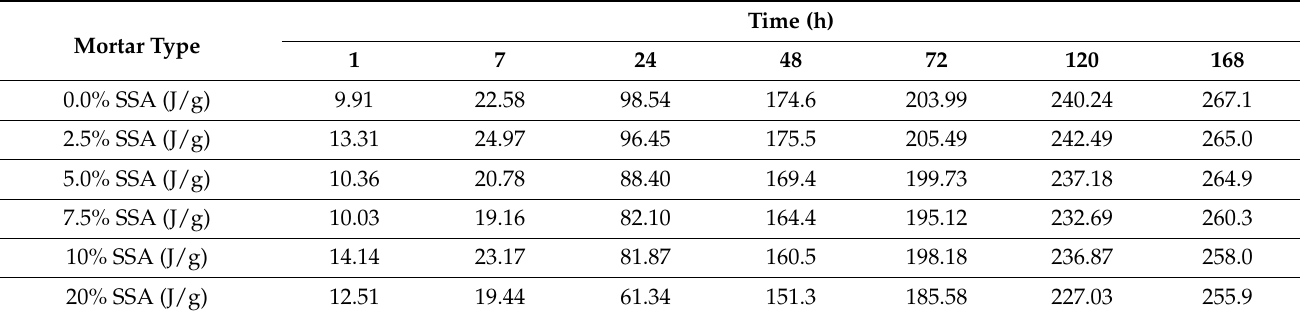
Table 6. Characteristic values of the hydration heat (J/g) evolved after hours for the cement